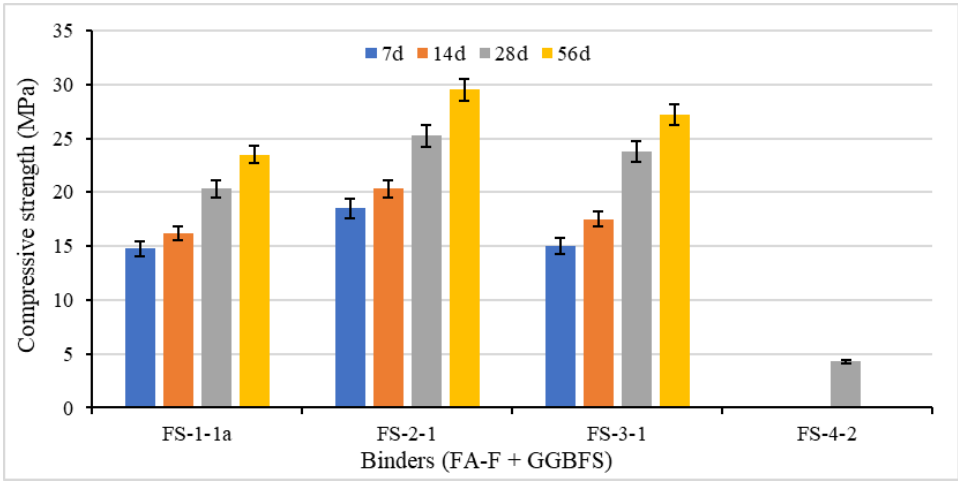
Figure 8. Influence of powder-based reagents on binary binders (FA-F + GGBFS). The binary binders composed with FA-C and FA-F as precursors and different com- binations/dosages of reagents, as illustrated in mix proportions presented in Table 5a,b, had long setting times (>24 h). These binder systems hence resulted in low compressive strengths ranging from 4 to 7.5 MPa at 28 days, respectively. These results can be attributed to the plausible leaching of Si and Al ions from the system, low reactivity of FA-F, and possible incompatibility of the reagent compositions with the binder systems.